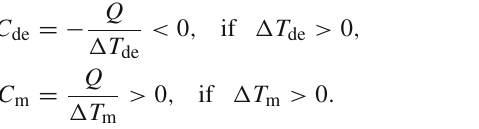
increases along the cosmic evolution, the dark matter tem- perature around z ≈ 2 changes its increasing tendency and around z = 0 . 2 its value increases